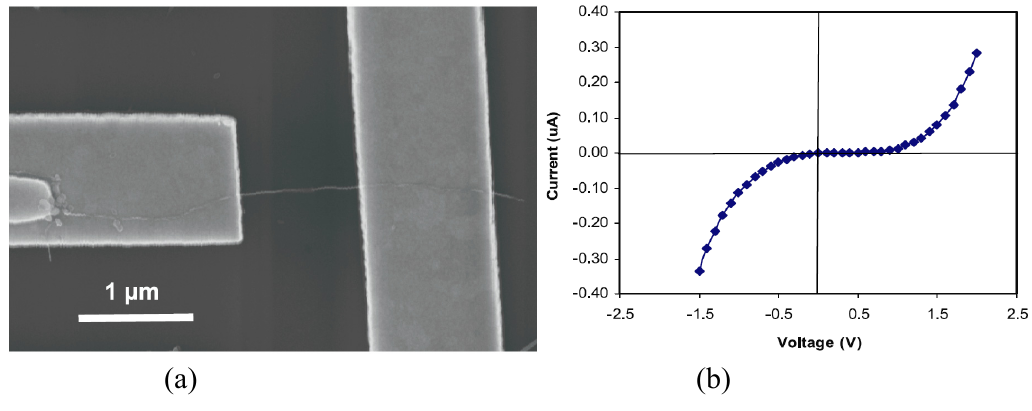
Figure 6. CNT biosensor: (a) SEM image of the assembled SWNT; and (b) I-V curve showing its semiconducting property (Reprinted from